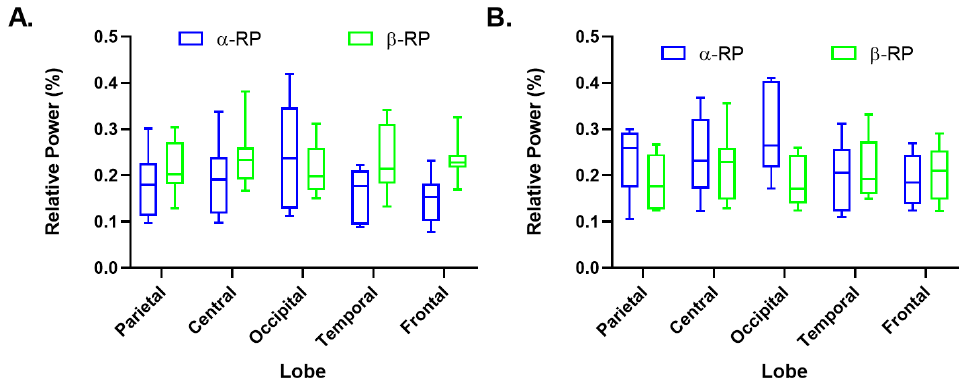
Figure 3. Distribution of the alpha and beta bands’ relative power by cerebral lobes of the control tests: ( A ) Opened eyes (OE). ( B ) Closed eyes